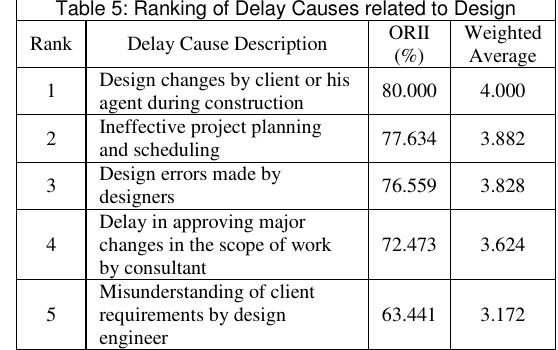
Table 5: Ranking of Delay Causes related to Design